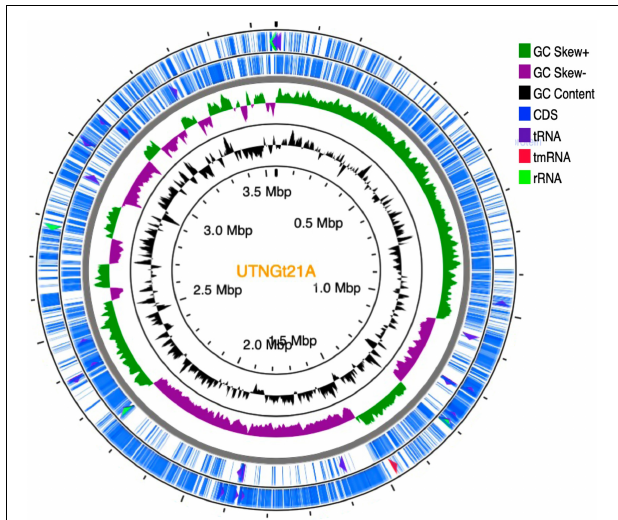
FIGURE 1 | Circular genome diagram of L. plantarum UTNGt21A. From the inner circle to the outer ring: the first ring shows the location of the